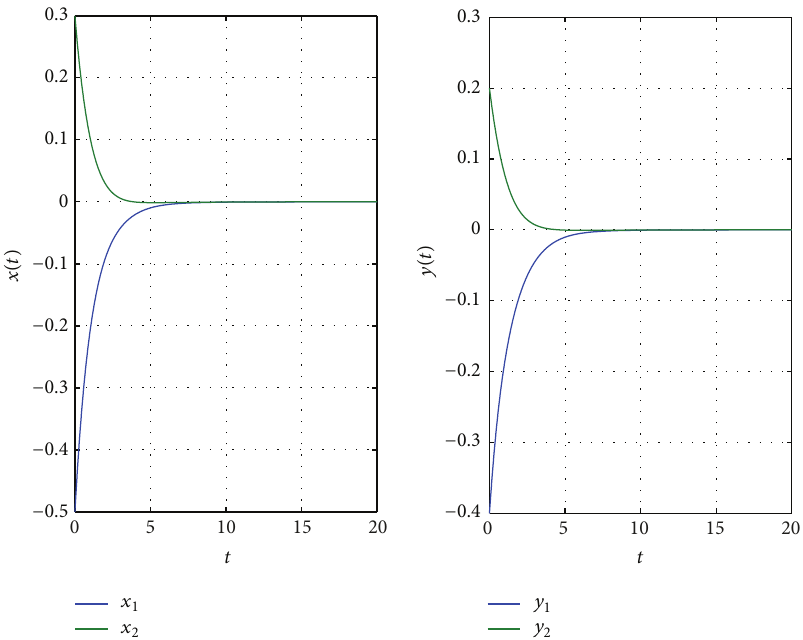
Figure 2: Trajectories of 𝑥(𝑡) and 𝑦(𝑡) of system (8) for the initial states 𝑥(0) = [−0.5 0.3] and 𝑦(0) = [−0.4 0.2]